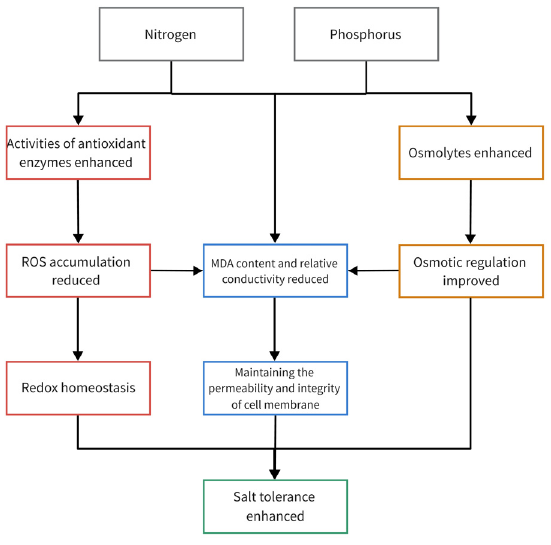
Figure 6. A schematic model depicting the alleviation induced by nitrogen and phosphorus on salt-affected sorghum.